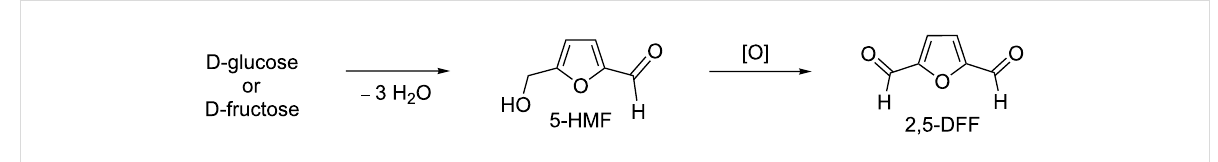
Figure 1: Formation of 5-HMF from D-glucose or D-fructose followed by oxidation to 2,5-DFF.